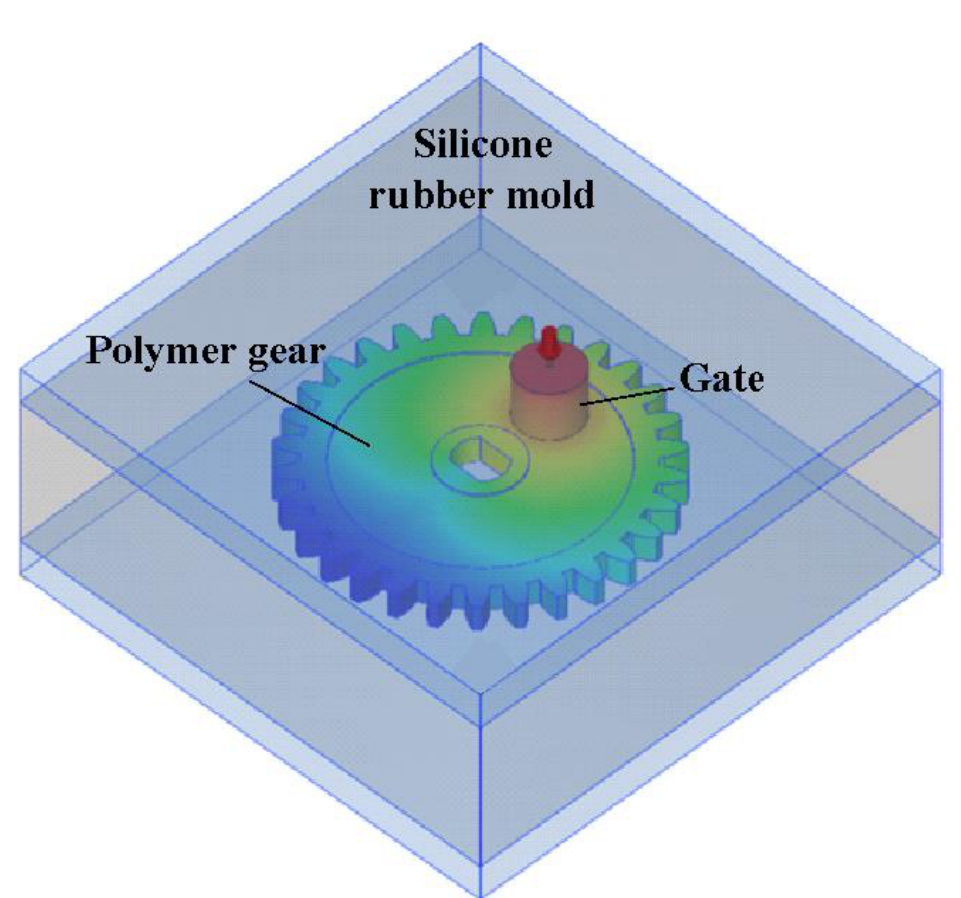
Figure 6. Relationship between filling system, cast part, and silicone rubber mold.